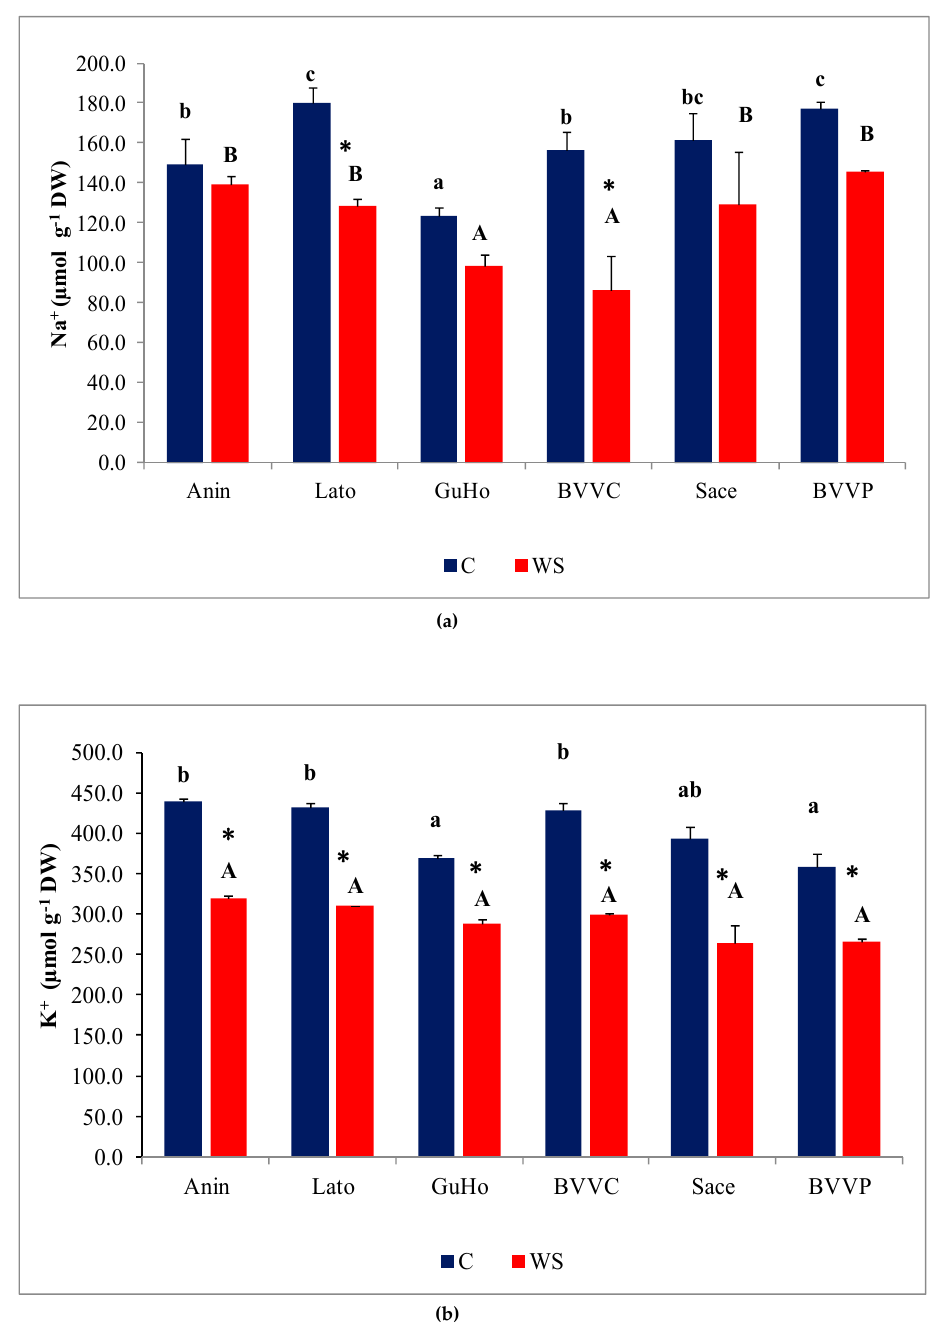
Figure 5. Needle cationic contents of six Romanian provenances of L. decidua after one month of applied drought stress (Mean ± SE, n = 5): ( a ) Sodium (Na + ) expressed in µ mol g − 1 DW; ( b ) potassium (K + ) expressed in µ mol g − 1 DW. Comparing provenances, di ff erent lowercase letters indicate significant di ff erences between control plants, and di ff erent uppercase letters indicate significant di ff erences between drought-a ff ected plants, according to Tukey’s test ( α = 0.05). Asterisks indicate a significant di ff erence between treatments within the same provenance, according to the LSD value for the interaction ( p =